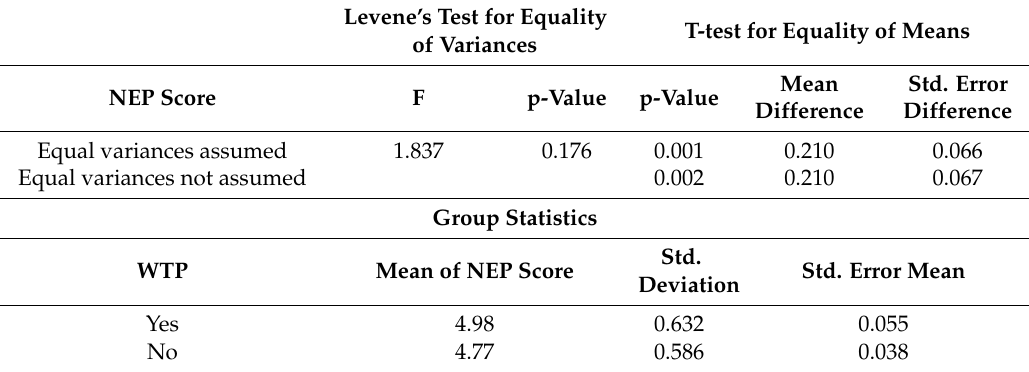
Table 6. Independent sample t-test between Willingness to Pay for green energy expansion (WTP) and mean New Environmental Paradigm Scale score (NEP) with diagnostic